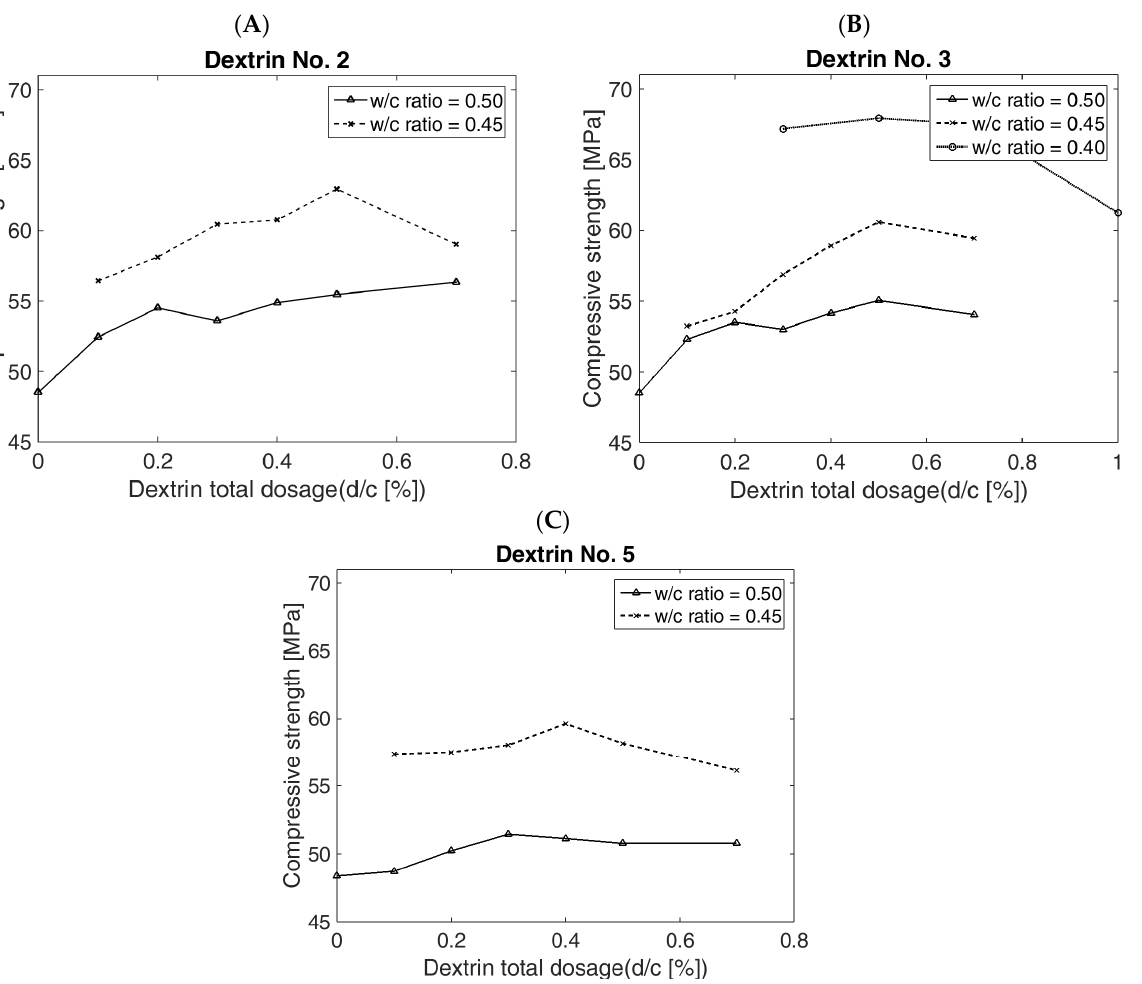
Figure 8. Compressive strength of cement mortars with the addition of: ( A ) Dextrin No. 2, ( B ) Dextrin No. 3, and ( C ) Dextrin No. 5.